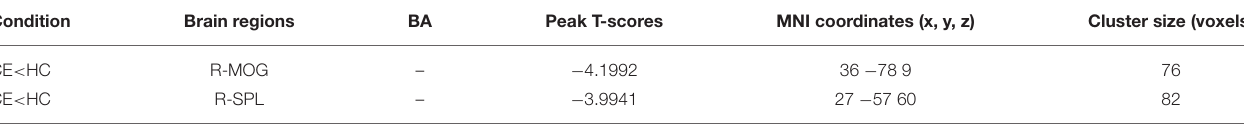
TABLE 3 | Different dALFF (window length = 70 TR, window step = 1 TR) values between two groups. Condition